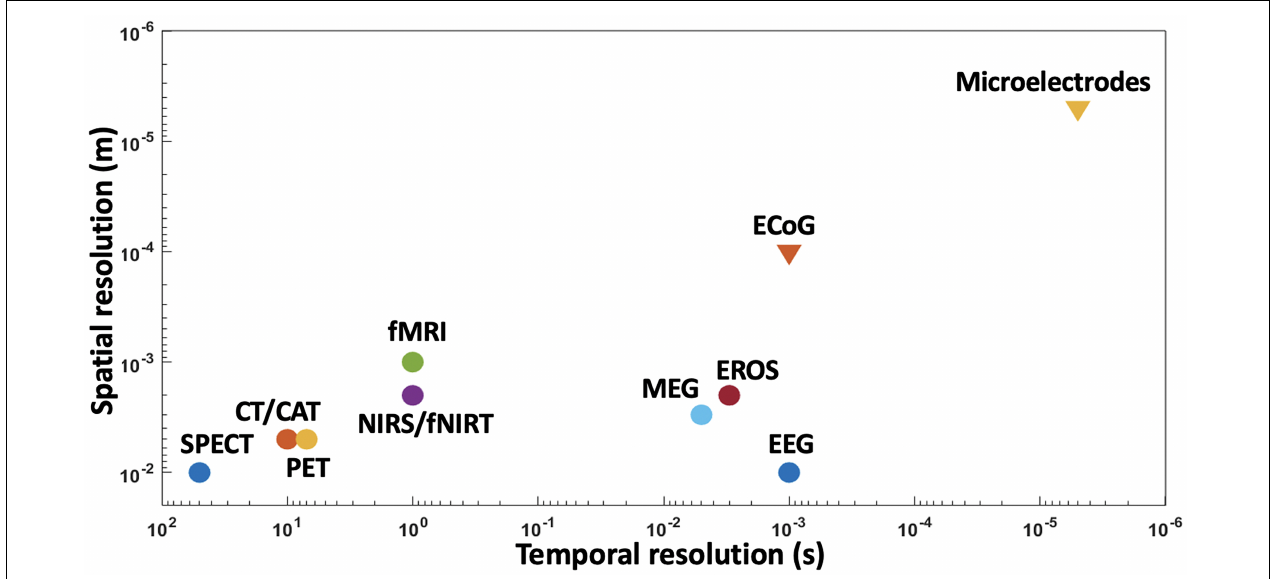
FIGURE 8 | Spatial and temporal resolutions of various BMI techniques, with microelectrodes showing higher resolutions than other